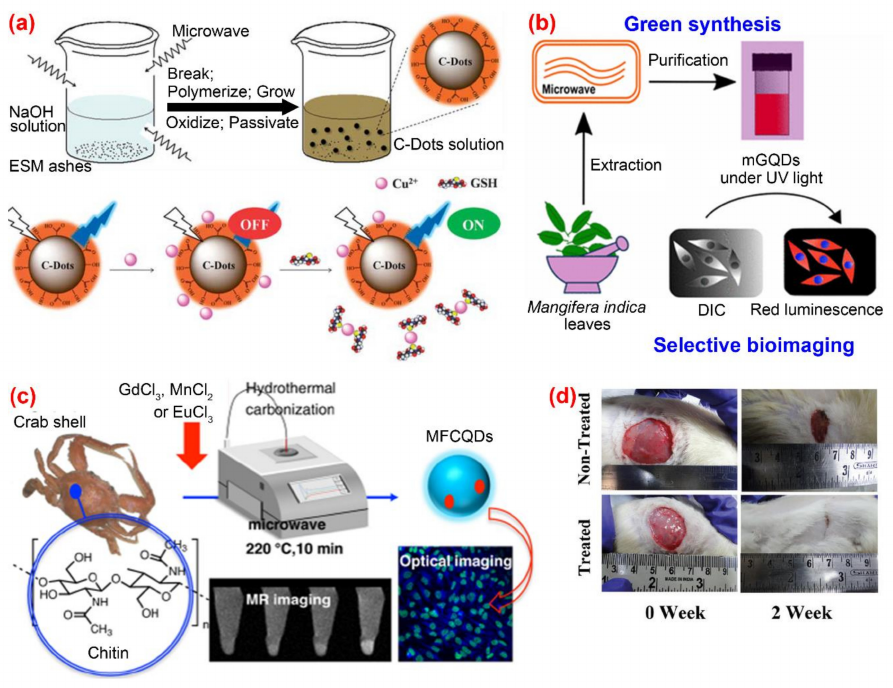
Figure 5. Preparation and application of fluorescence C-dots from biomass wastes by microwave-assisted approaches. ( a ) The preparation and application of C-dots from eggshell membranes [79]; ( b ) the synthesis and application of C-dots from mango leaves [80]; ( c ) the preparation and application of C-dots from crab shell [81]; ( d ) application of C-dots synthesized from onion peel to test the e ffi cacy in accelerating wound healing [82].